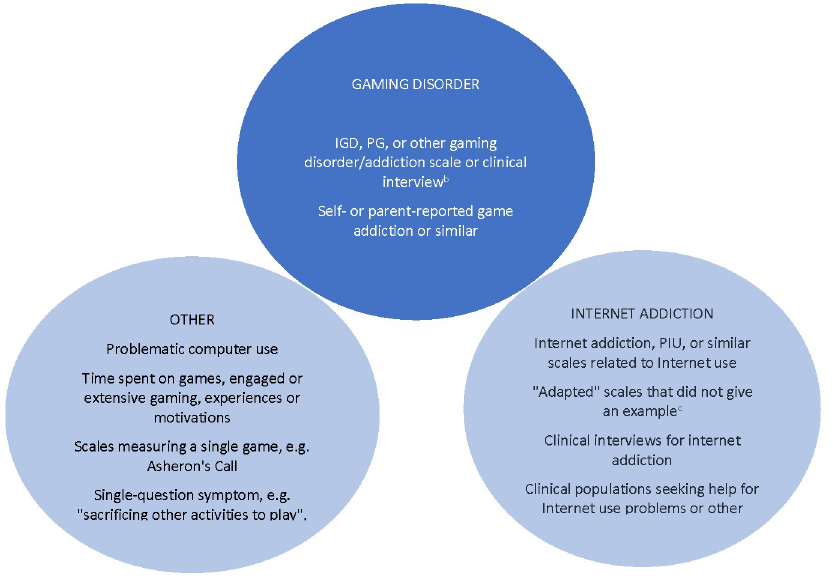
Fig 3. Domains used to define gaming disorder as a construct for analysis. IGD = Internet gaming disorder; PG = problematic gaming; PIU = problematic Internet use. (a) Sensitivity analysis: Clinical population of those seeking help for gaming-related problems but an Internet addiction scale was used. (b) Including those adapted from Internet addiction scales where an example question is given. (c) Where scales referenced appendices or other papers, these were also searched for example